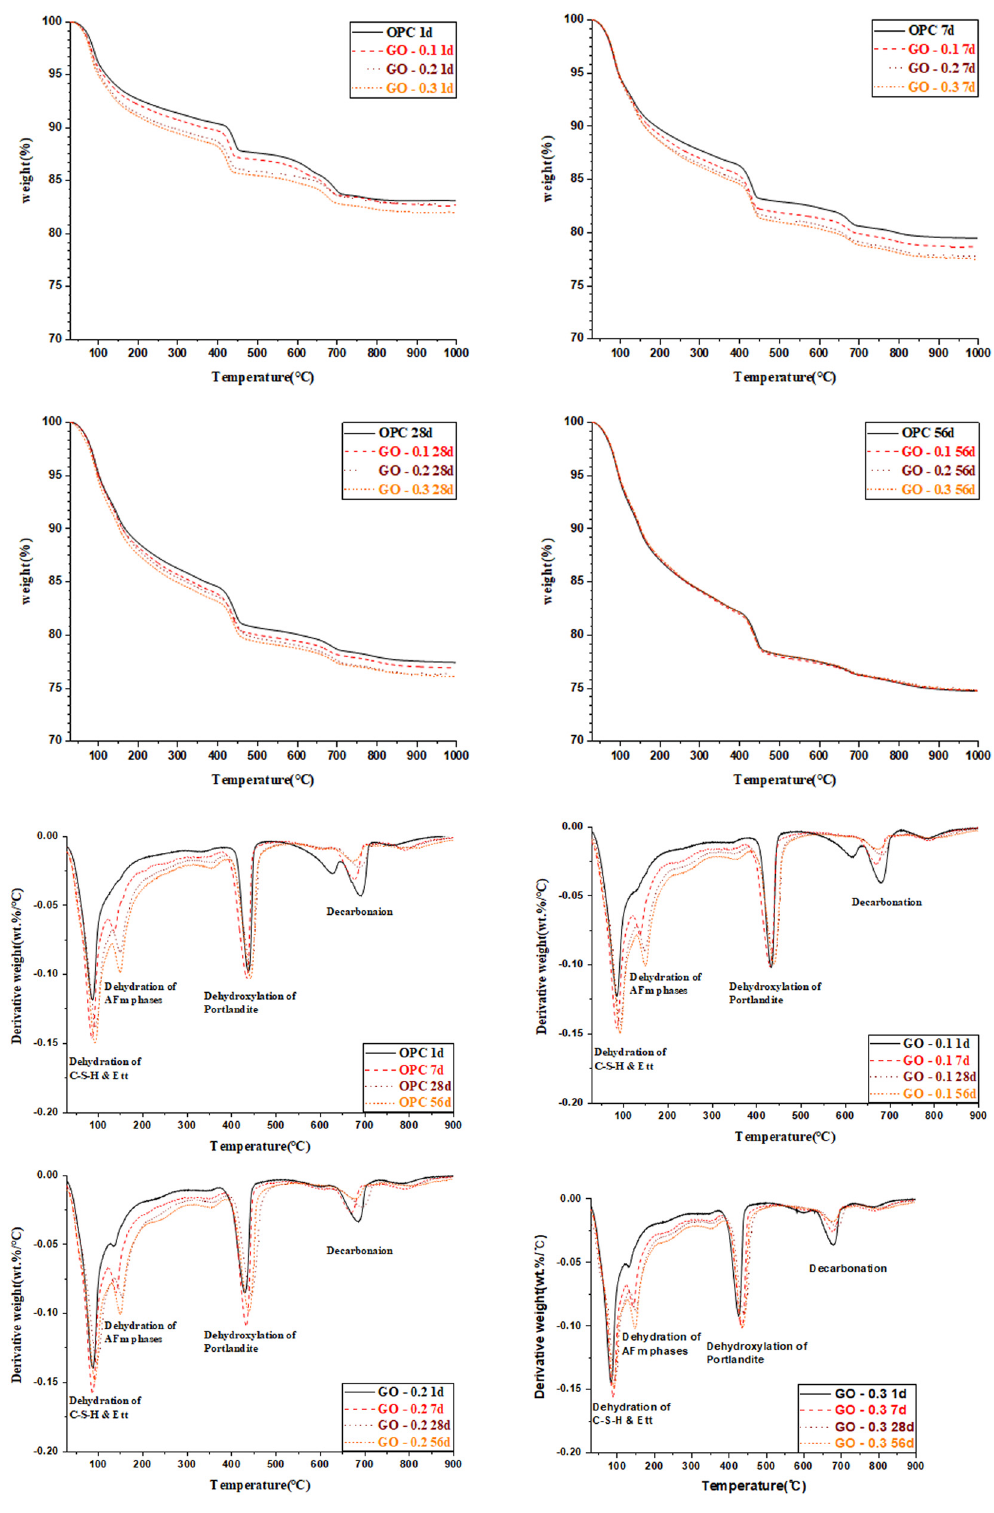
Figure 6: TG results for the